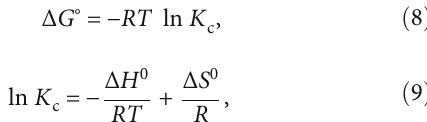
Table 5: Comparison of the MG adsorption capacity of Fe Adsorbent